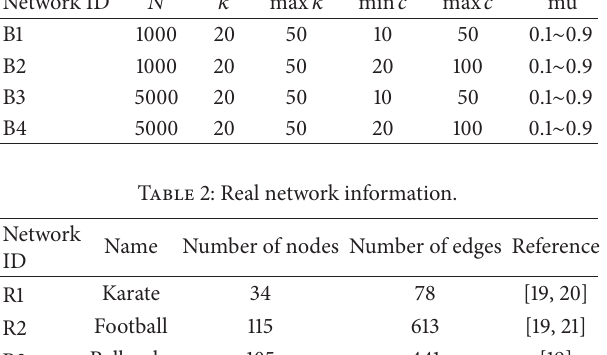
Algorithm 2: Local community detection.